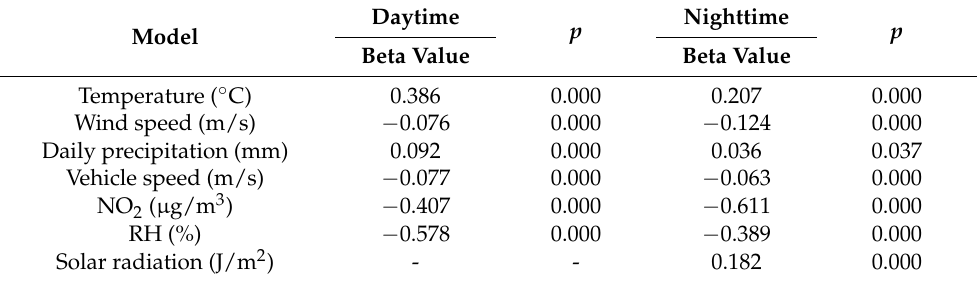
Daytime Nighttime p p Beta Value Beta Value